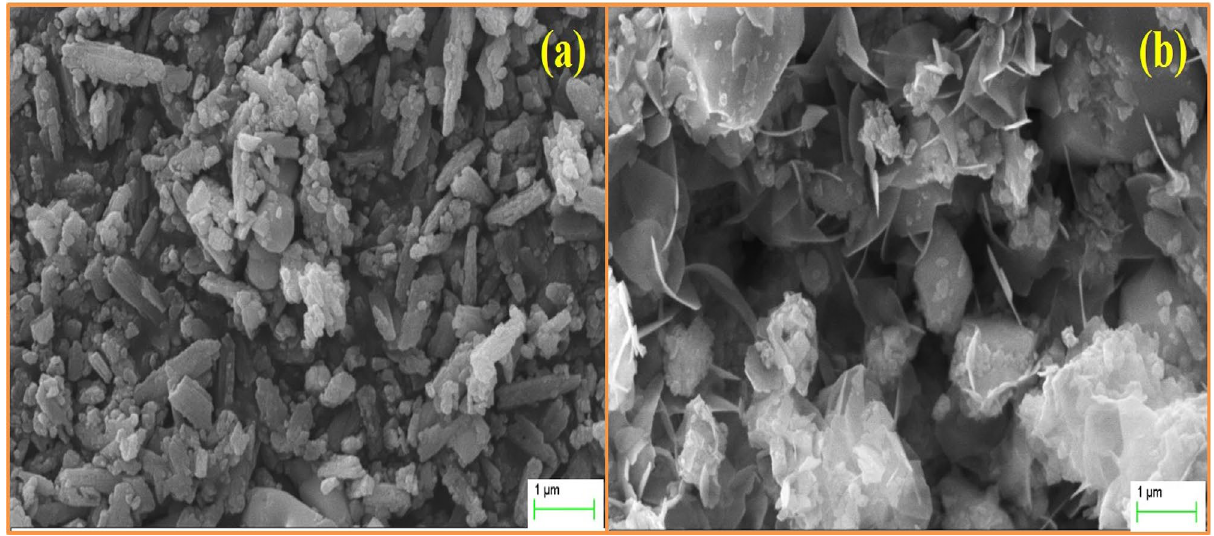
Figure 2. The SEM images of ( a ) Ho 3+ /Yb 3+ /0Bi 3+ and ( b ) Ho 3+ /Yb 3+ /5Bi 3+ co-doped phosphor materials.